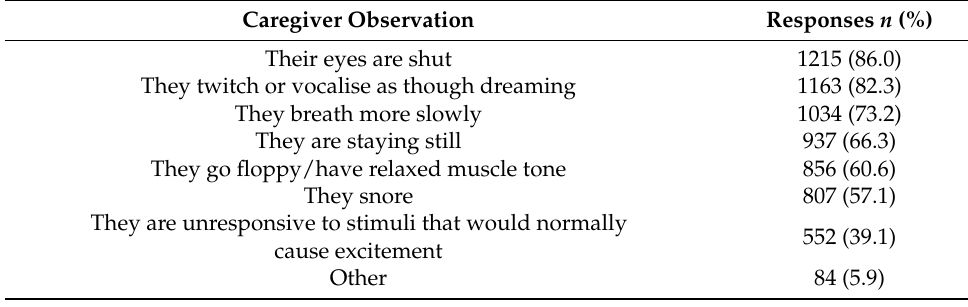
Table 3. A summary of caregiver observed sleeping behaviours ( n = 1327 respondents).